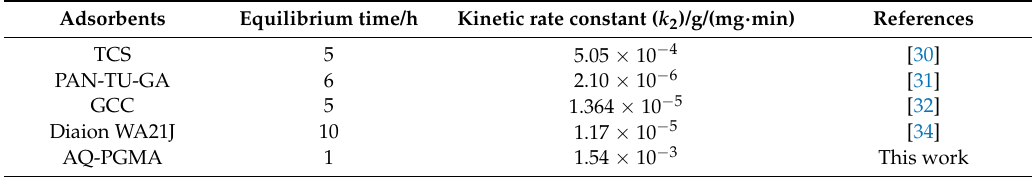
Table 3. The equilibrium time and kinetic models rate constant of AQ-PGMA and other adsorbents in